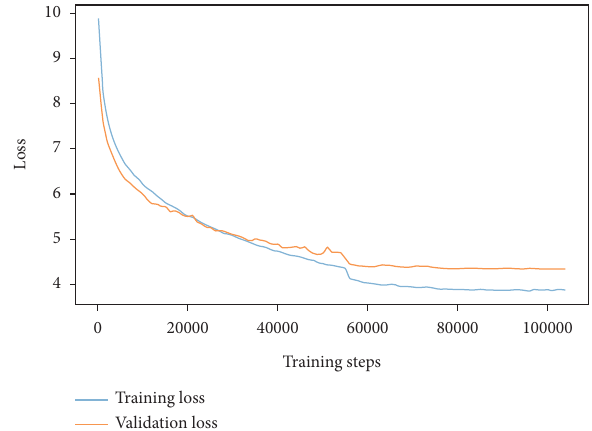
Figure 7: Variation of the three indicators in the training